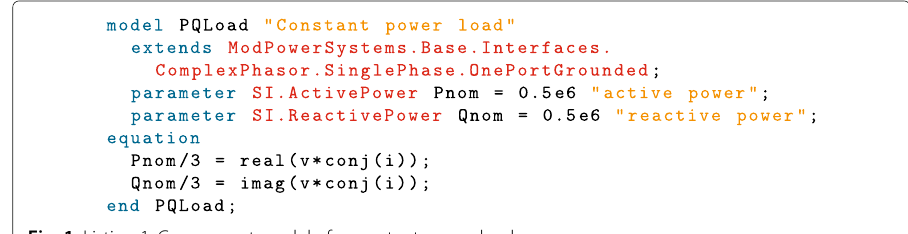
Fig. 1 Listing 1: Component model of a constant power